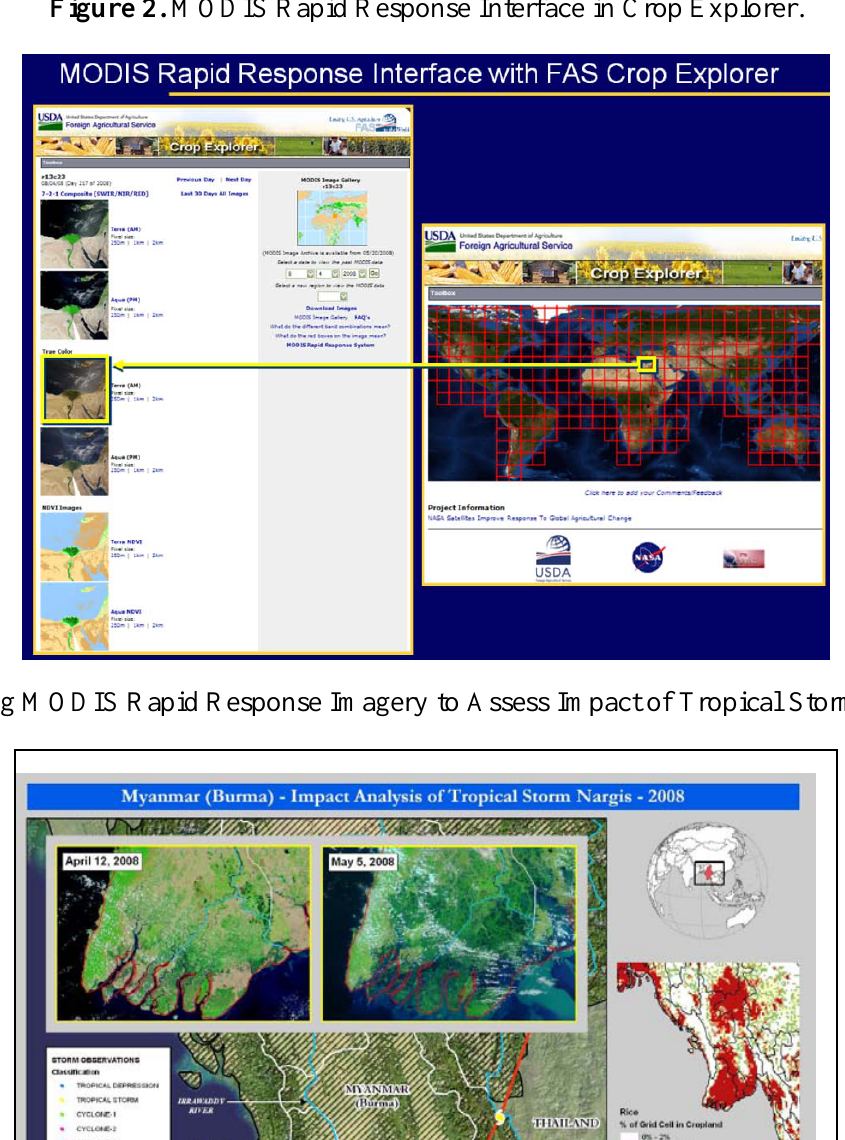
Figure 2. MODIS Rapid Response Interface in Crop Explorer.